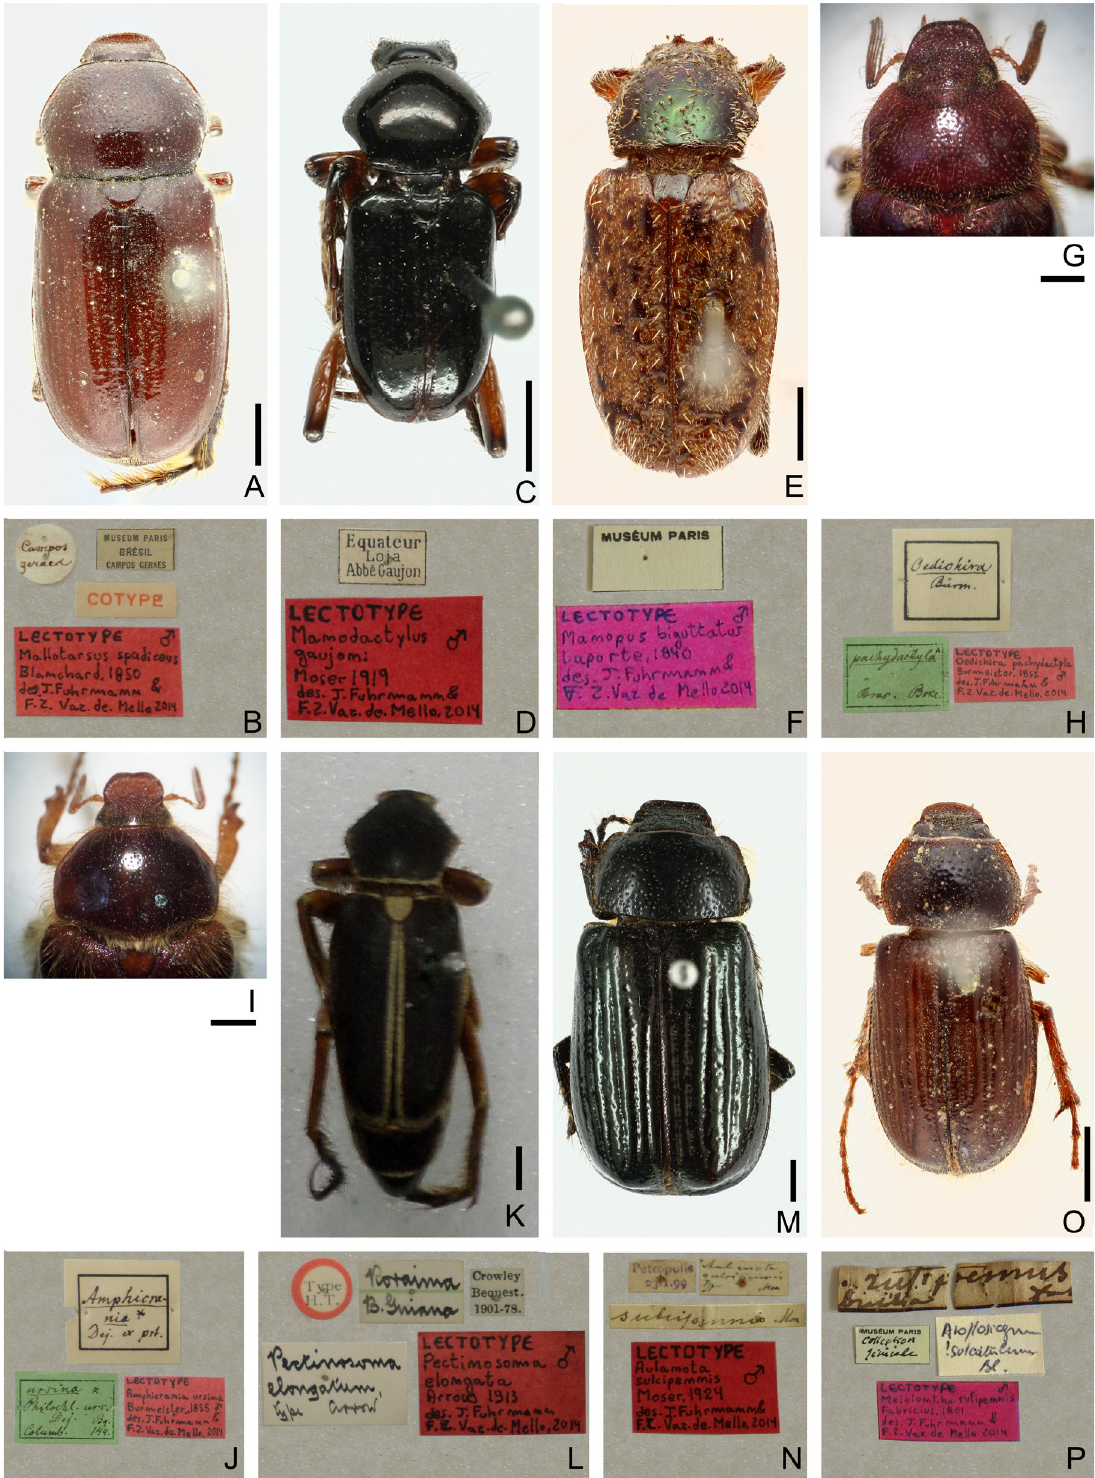
Fig 19. Lectotypes (dorsal, labels). A–B . Mallotarsus spadiceus Blanchard, 1850. C–D .